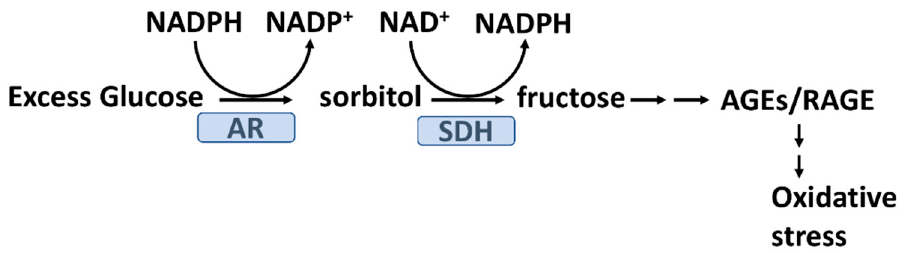
Figure 3. The polyol pathway and oxidative stress. For cells in which hyperglycemia produces high intracellular glucose levels, the polyol pathway is activated. Excess intracellular glucose is converted to sorbitol by the action of aldose reductase (AR), which consumes NADPH. NADPH is required to recycle oxidized glutathione (GSSG) to reduce glutathione (GSH) and reduce peroxides (see Figure 1), which would otherwise cause oxidative stress. Sorbitol is converted to fructose by sorbitol (SDH). Fructose is an effective glycating sugar-forming AGEs that promote oxidative stress and inflamma- tion.